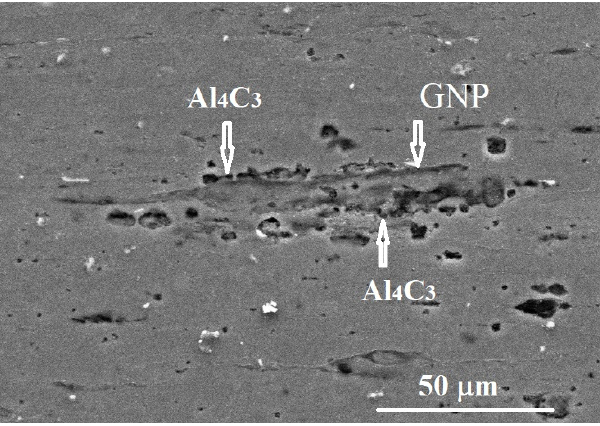
Figure 3. SEM images of GNP and supposed nano-sized Al 4 C 3.